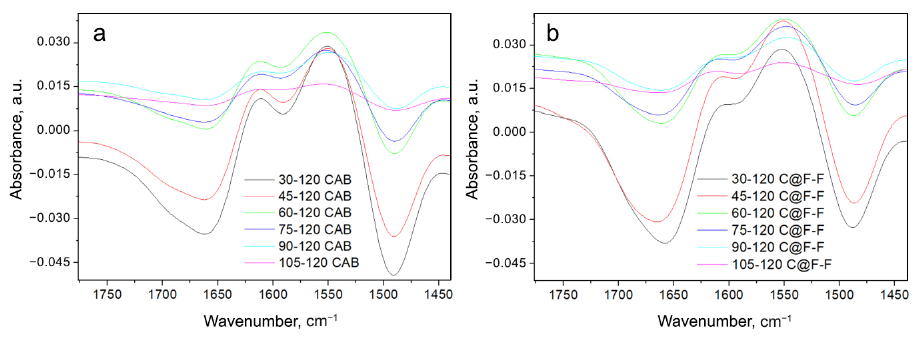
Figure 5. Difference spectra for CAB ( a ) and C@F-F ( b ), indicated through the label. Each spectrum is obtained as a difference between the spectrum obtained at a particular temperature and the one at 120 ◦